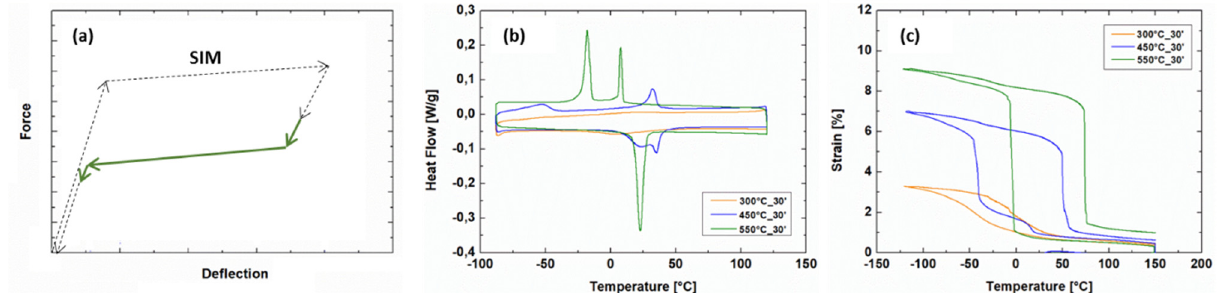
Figure 1. ( a ) Schematic representation of the flag-shaped pseudoelastic response, where the green line is the unloading path exploited in biomedical applications. ( b ) Effect of annealing temperature on the phase transformation temperatures of a body-temperature NiTi wire determined with differential scanning calorimetry (at 10 °C/min in the range − 90–120 °C). ( c ) Effect of annealing temperature on the strain-recovery response of a body-temperature NiTi wire (under a constant load of 150 MPa, at 5 °C/min in the range − 120–150 °C). Each heat treatment was done for 30 min and followed by a water quench [13].